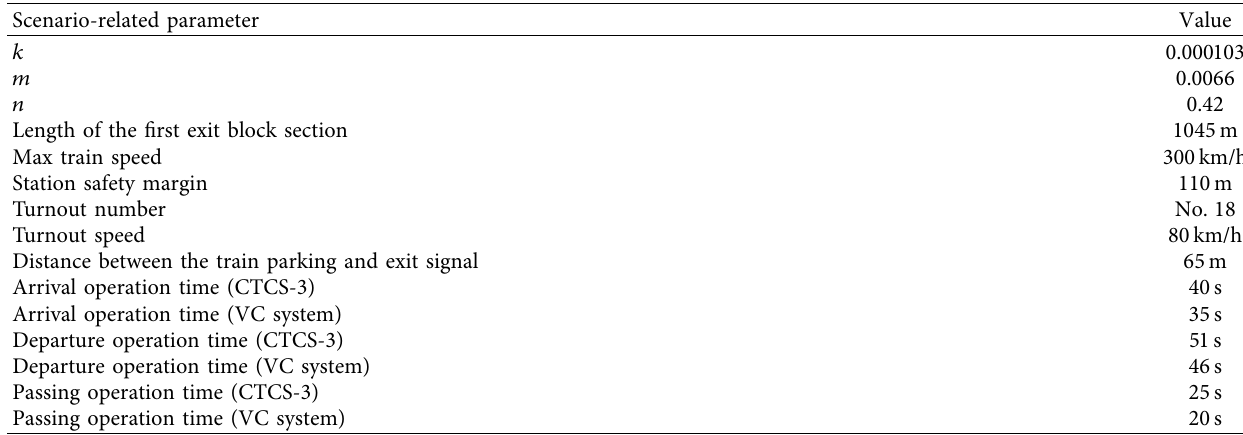
Table 6: Scenario-related parameters for CTCS-3 and VC